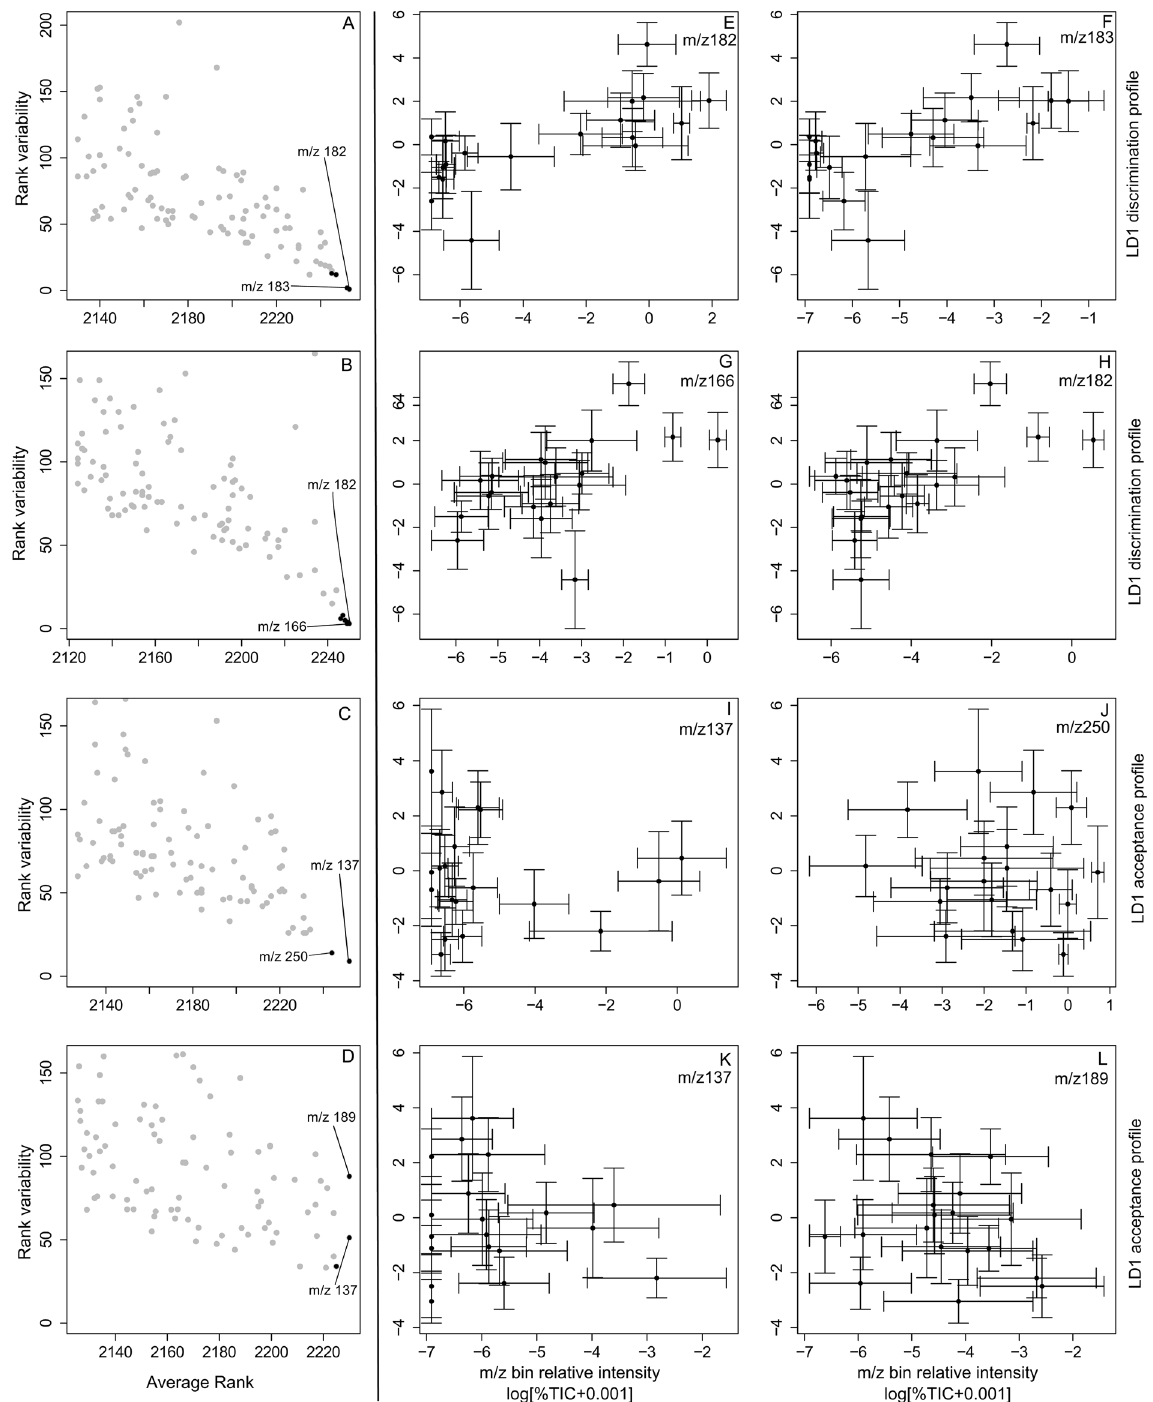
Figure 2. Results of Random Forest analyses and correlation of abundance in top ranking m/z bins with LD1 profile. A-D; Rank variability (interquartile range) as a function of median rank for the RF importance score (mean decrease in Gini coefficient) of the top 100 m/z bins from 500 runs of the RF regression models: LD1 discrimination profile against ( A ) polar and ( B ) non-polar metabolic data and LD1 overall acceptance profile against ( C ) polar and ( D ) non-polar metabolic data. m/z bins with the highest average rank best explain variation in LD1 profile and greater confidence can be placed in bins with low rank variability. Points in black are key m/z bins used for further investigation. ( E – L ) Correlations between key m/z bin values highlighted by RF models and LD1 scores. Mean ± SEM, Significance tested using Spearman’s rank correlation with FDR correction: NS – not significant, * P < 0.05, ** P < 0.001, *** P <